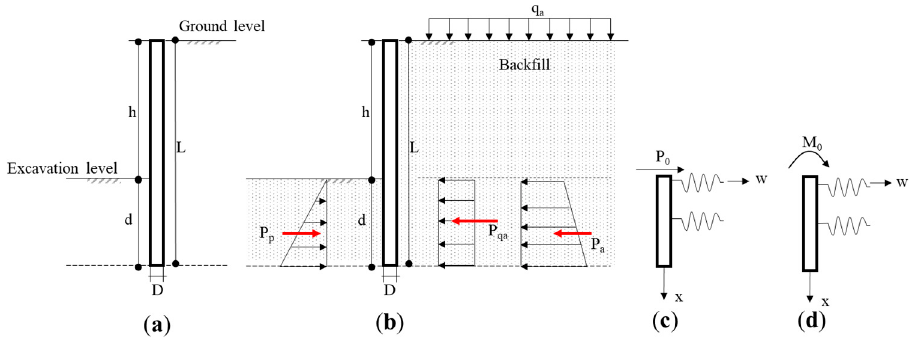
Figure 1. The cross-section of a cantilever soldier pile ( a ); Distribution of earth pressure along the pile ( b ); Continuous elastic support assumption ( c , d ( b ); Continuous elastic support assumption ( c , d ).